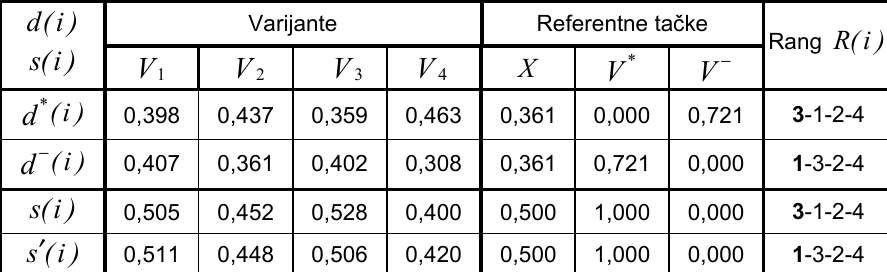
Table 5 – Values of the Lp metrics linear combination and the similarity to ideal vector Varijante Referentne ta č ke